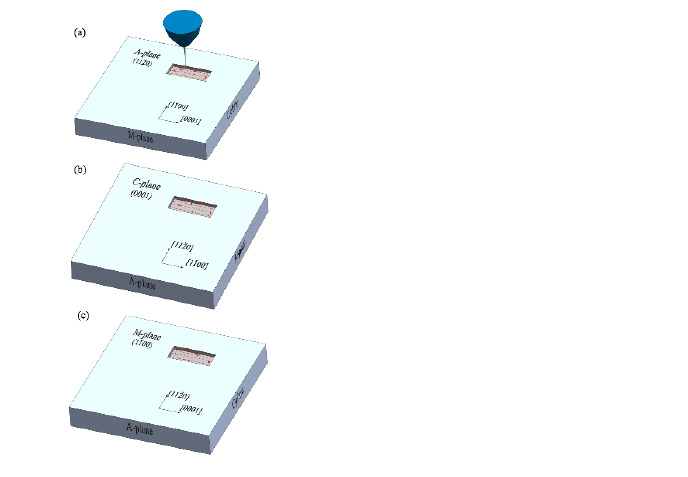
Figure 1. Schematic of rectangular pits on A-plane ( a ), C-plane ( b ), and M-plane ( c ) sapphires fabricated by focused ion beam (FIB) milling.